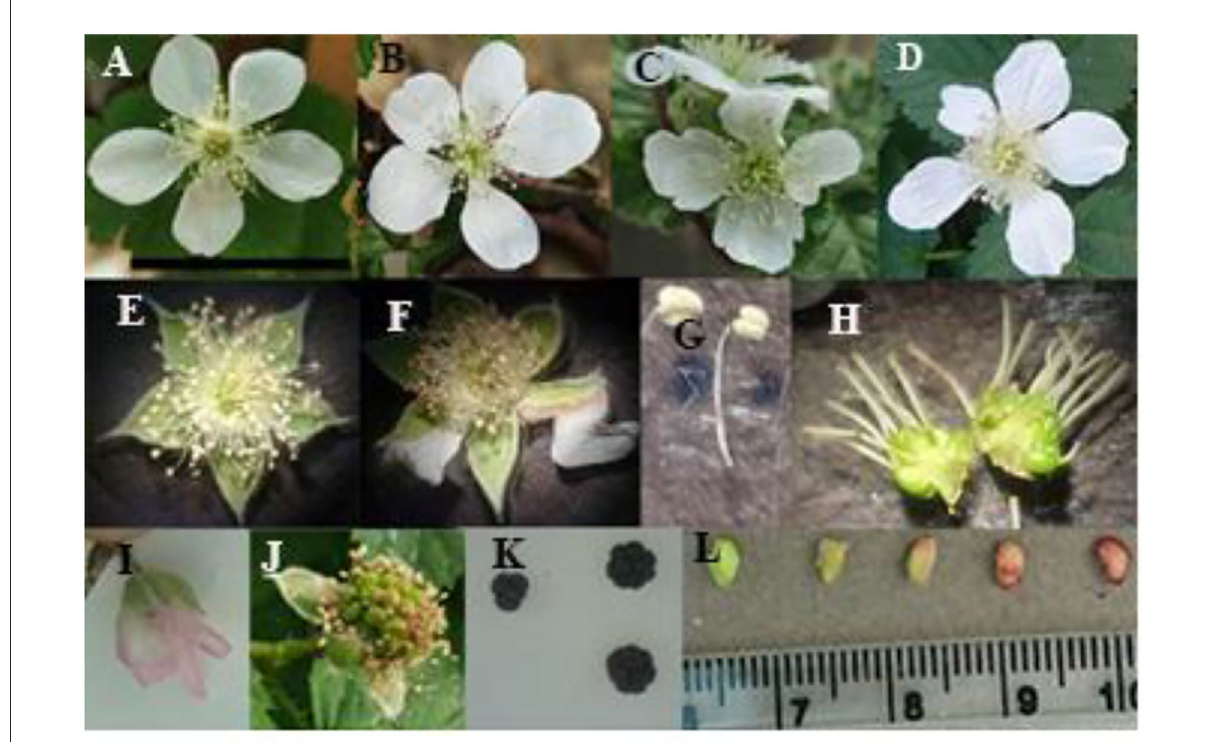
FIGURE2 Morphological characteristics of flower, fruit, and seed in diploid and polyploid blackberries. (A) Diploid flower, (B) tetraploid flower, (C,D) octaploid flower, (E) normal stamen, anther, and sepal, (F) browned anther, abnormal sepal in tetraploid flower, (G) diploid (right) and polyploid (left) stamen, (H) diploid (left) and octaploid (right) ovary and pistil, (I) change in color of petal after pollination in polyploid plants, (J) fruit set, (K) fruit size and shape in diploid (left) and octaploid (right), (L) different stages of seed growth (the scale bar showed